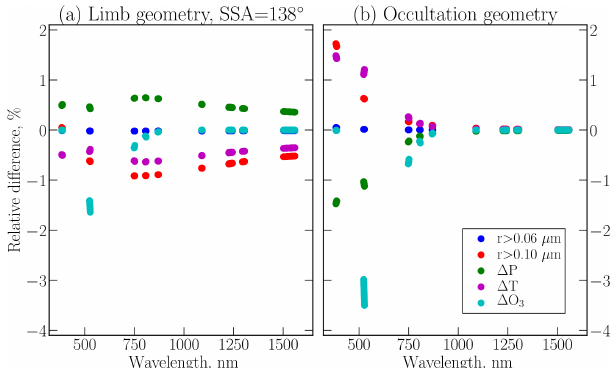
Figure 2. Relative changes in the radiance at 21.7km for limb (a) and occultation (b) geometry. The responses in radiance due to 10% changes in temperature and atmospheric pressure and 5% changes in ozone concentration are presented by magenta, green and cyan dots, respectively. The cutoff in PSD at 0.06µm is depicted with blue dots, and the cutoff at 0.10µm is presented with red